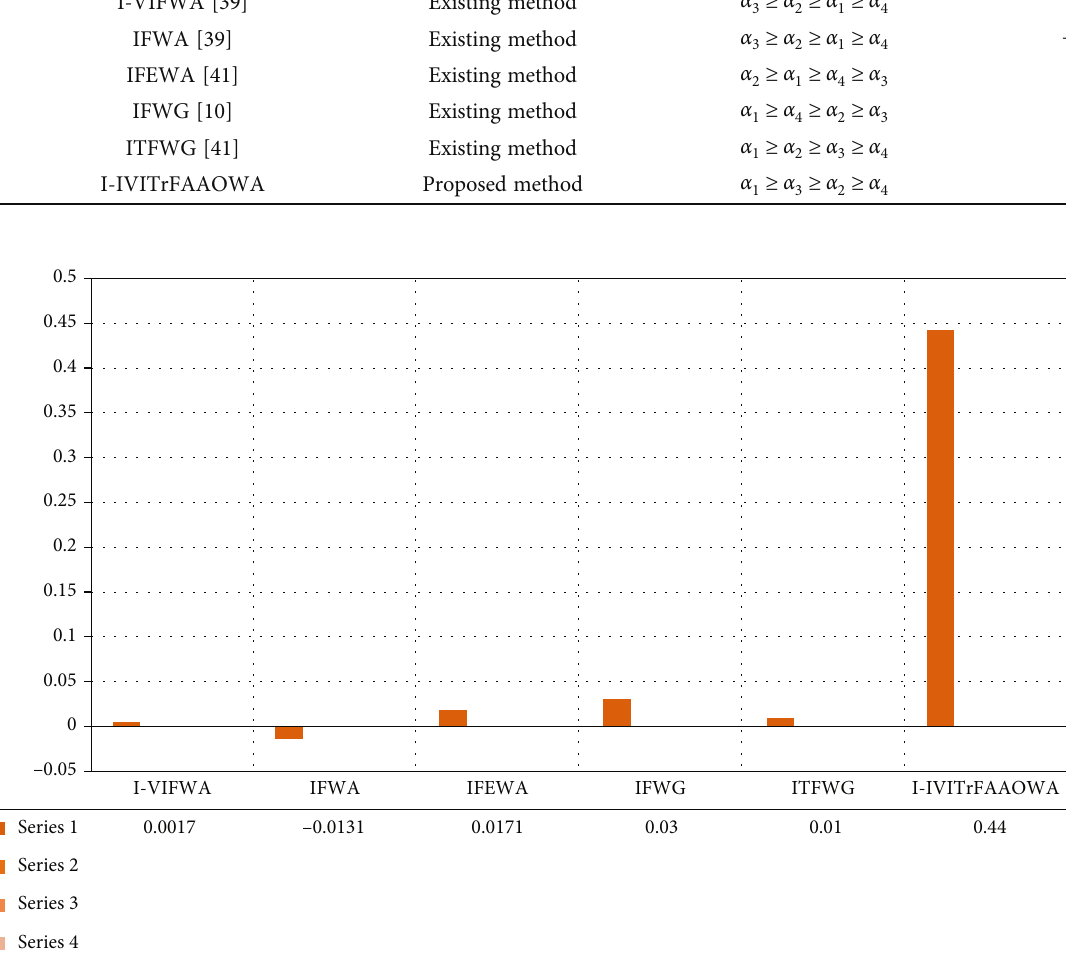
Figure 4: Graphical presentation of comparison analysis.